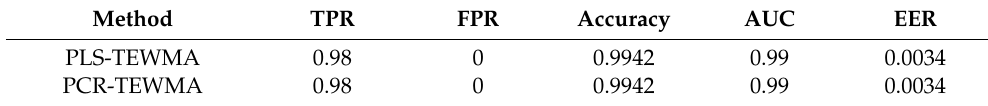
Figure 13. Detection results of ( a ) PLS and ( b ) PCR-based TEWMA charts in the presence of string fault. Table 3. Results of PLS-based and PCR-based TEWMA charts under string fault. Table 3. Results of PLS-based and PCR-based TEWMA charts under string fault.